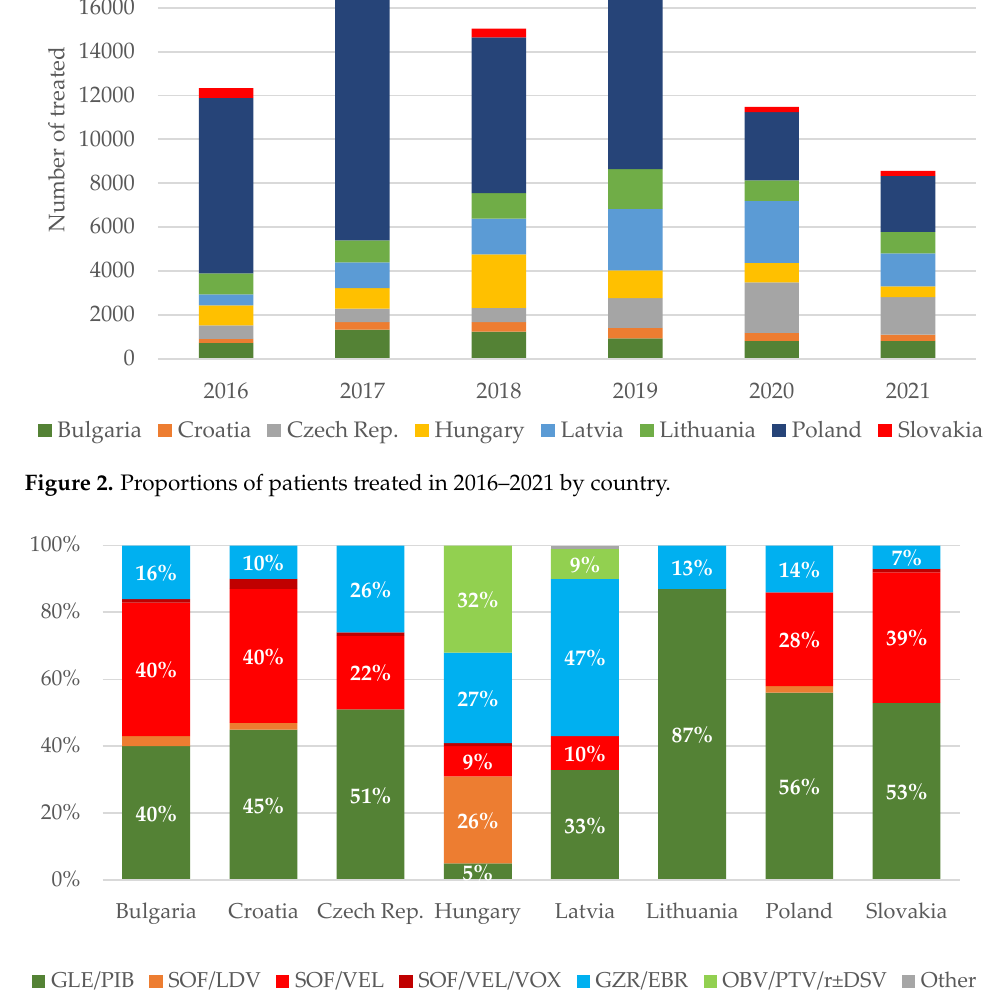
Figure 3. Proportions of regimens administered in 2020/2021 by country; glecaprevir/pibrentasvir (GLE/PIB), sofosbuvir/ledipasvir (SOF/LDV), SOF/velpatasvir (SOF/VEL), SOF/VEL/voxilaprevir (SOF/VEL/VOX), grazoprevir/elbasvir (GZR/EBR), ombitasvir/paritaprevir/ritonavir ± dasabuvir (OBV/PTV/r ± DSV).